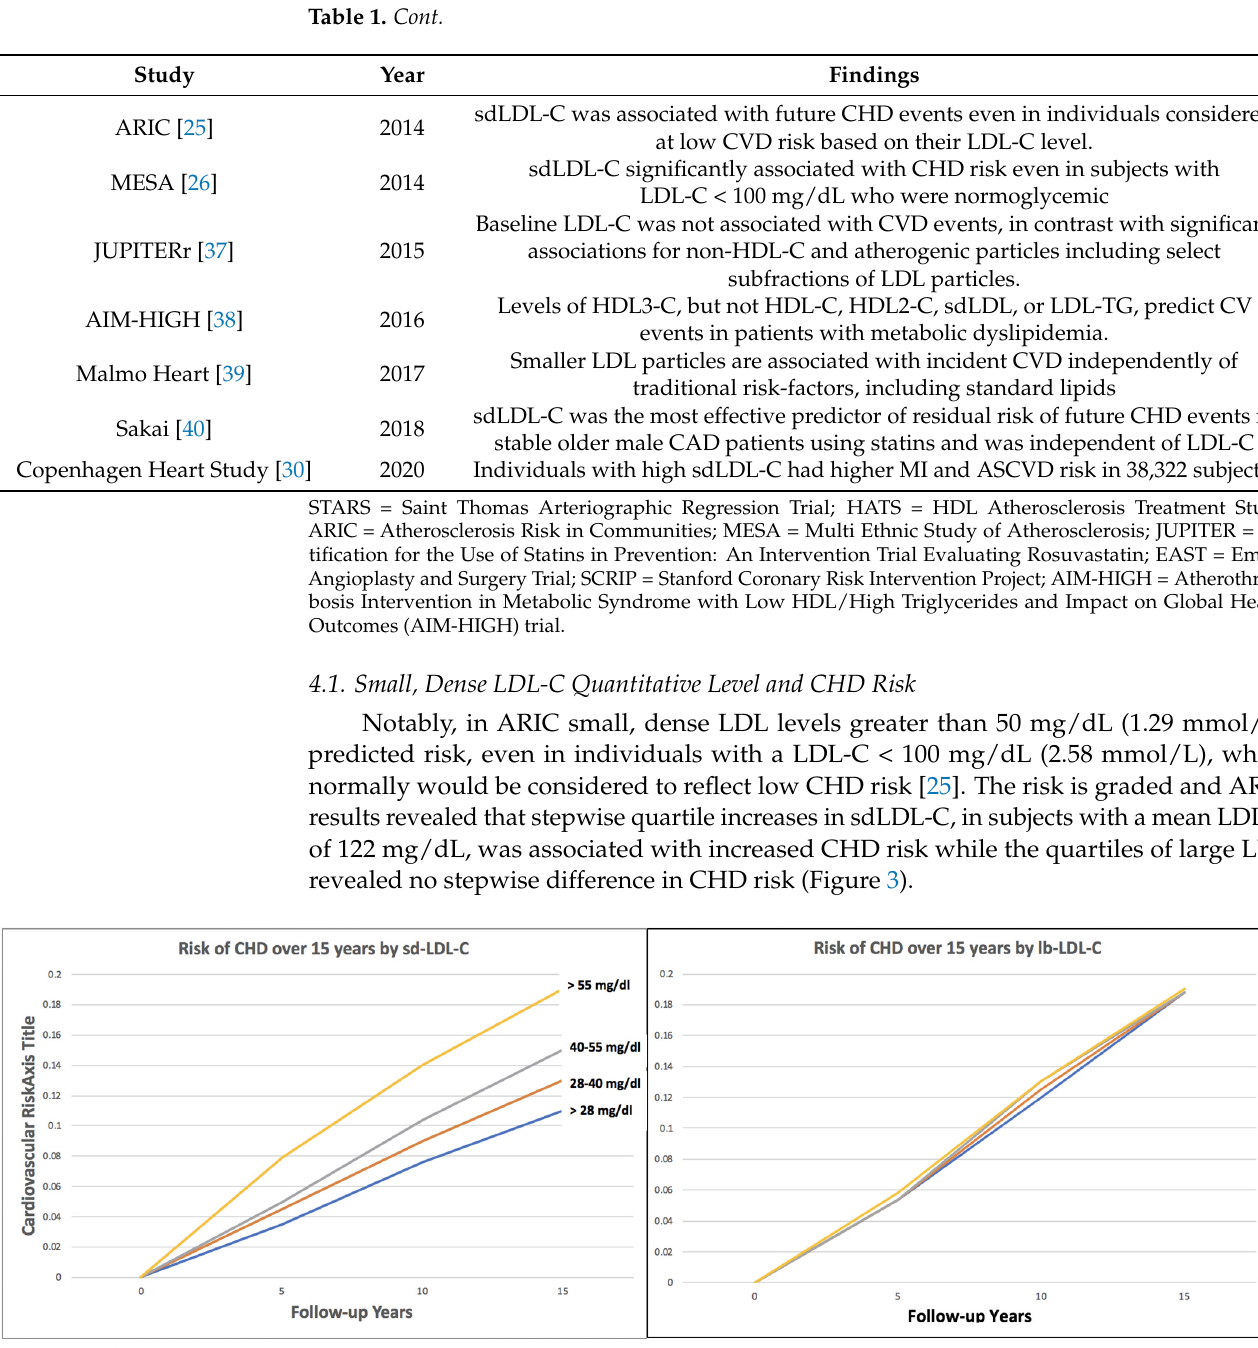
Figure 3. Small dense LDL ‐ C (sd ‐ LDL ‐ C) quartiles and large buoyant LDL ‐ C (lb ‐ LDL ‐ C)